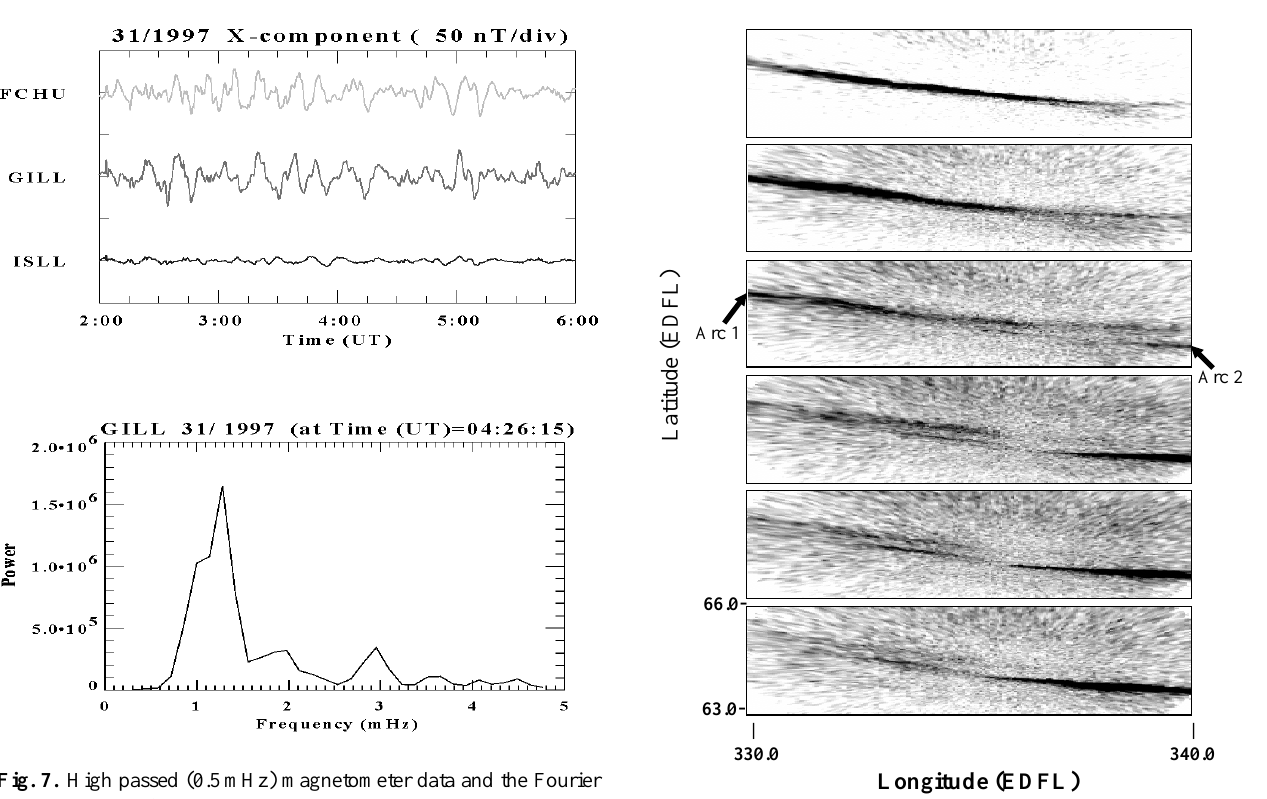
Fig. 8. ASI images of the 630.0nm auroral arc associated with the 1.3mHz FLR. The grey scale ranges from 0 (white) to 600R (black). The times of the images (top to bottom) are 04:22:03, 04:24:03, 04:26:03, 04:28:03, 04:29:03,